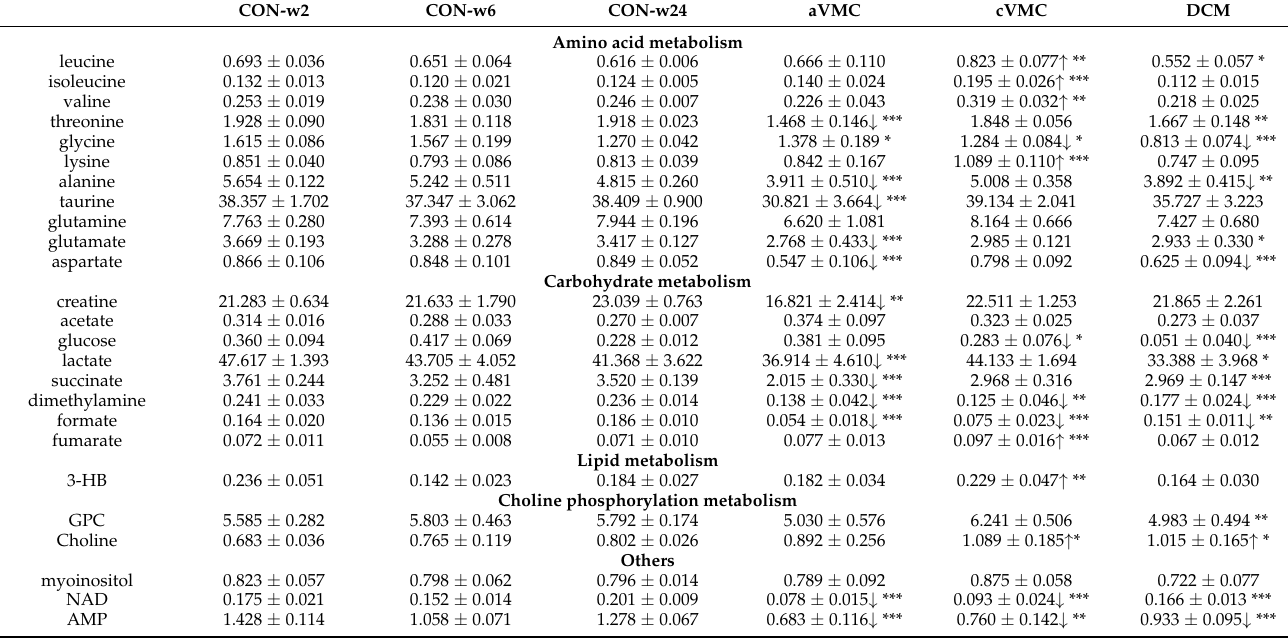
Table 1. Relative levels of metabolites calculated from 1D 1 H-NMR spectra of cardiac tissues derived from the six groups of